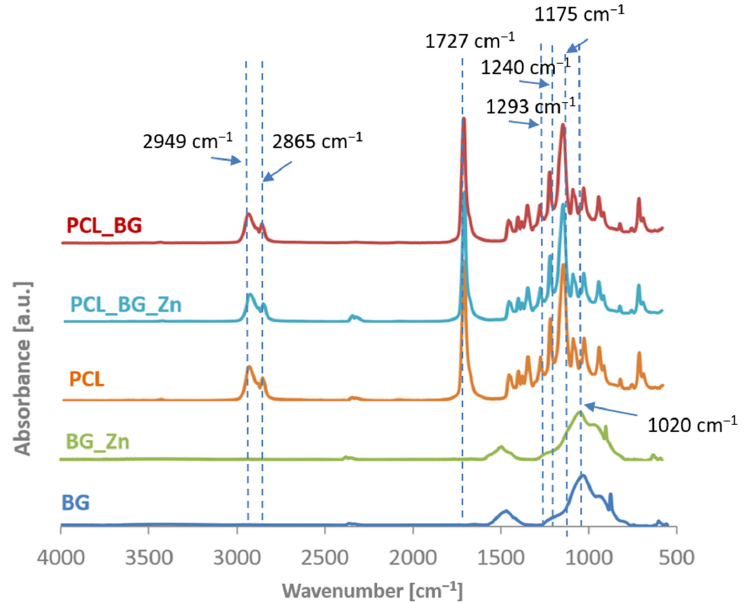
Figure 4. ATR-FTIR spectra of PCL_BG; PCL_BG_Zn; PCL; filaments, BG_Zn powder, and BG Figure 4. ATR - FTIR spectra of PCL_BG; PCL_BG_Zn; PCL; filaments, BG_Zn powder, and BG pow- der.